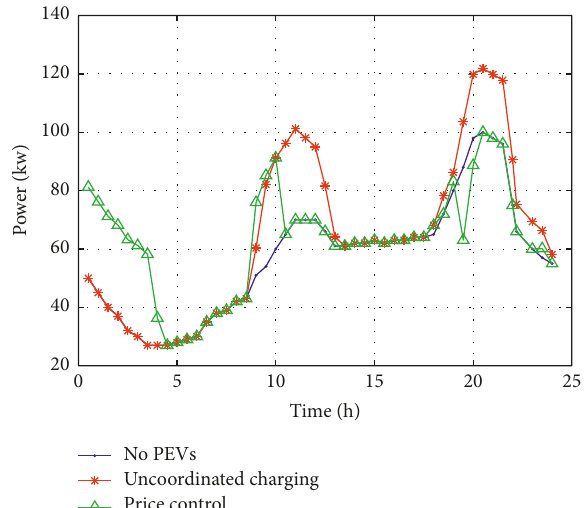
Figure 6: The load power curve after price-optimized coordination.